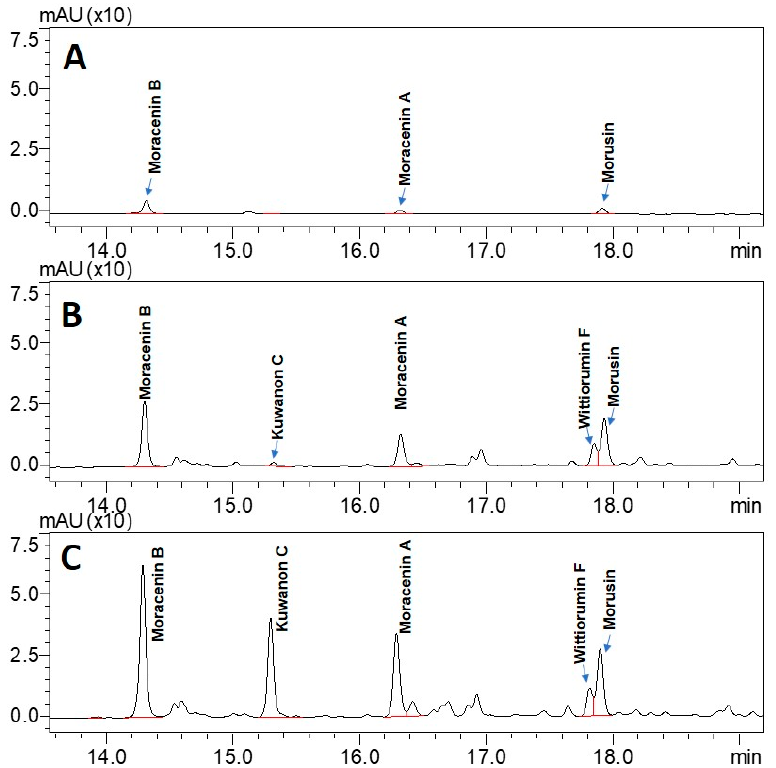
Figure 3. UHPLC chromatograms of the extracts obtained from commercially available roots ( A ), from control roots cultivated in aeroponic system ( B ) and from roots stimulated with nitrogen deficiency ( C ). All chromatograms were acquired at 265 nm.